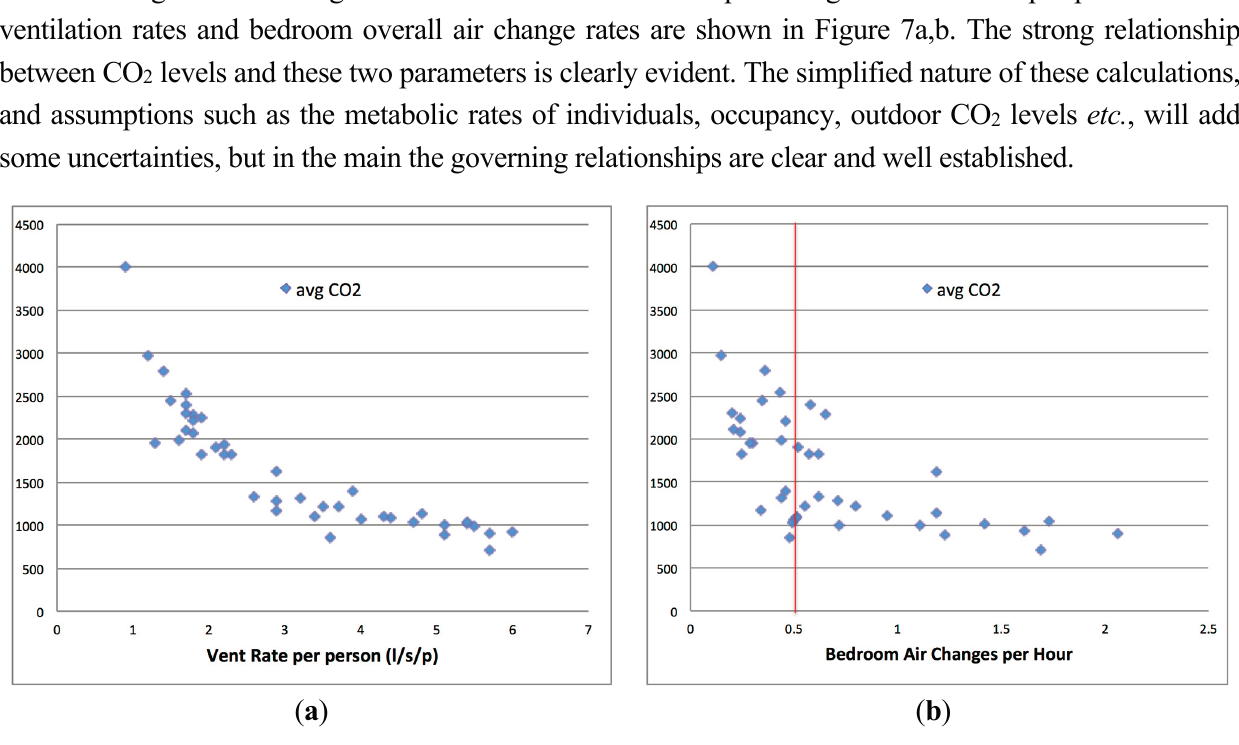
Figure 7. ( a ) Average bedroom CO 2 level v. ventilation rate per person ( b ) Average bedroom CO 2 level v bedroom air change